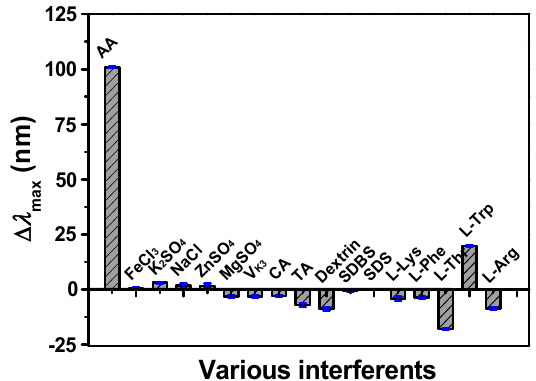
Figure 7. Selectivity of the proposed method for AA detection. Conditions: Au@Ag NRs, 50 μ L; H 2 O 2 , 450 μ M; Fe 2+ ; 0.25 mM; HCl, 0.10 M; t, 25 min; T, 45 °C; AA, 17.5 μ M; and other interfering species, 87.5 μΜ .